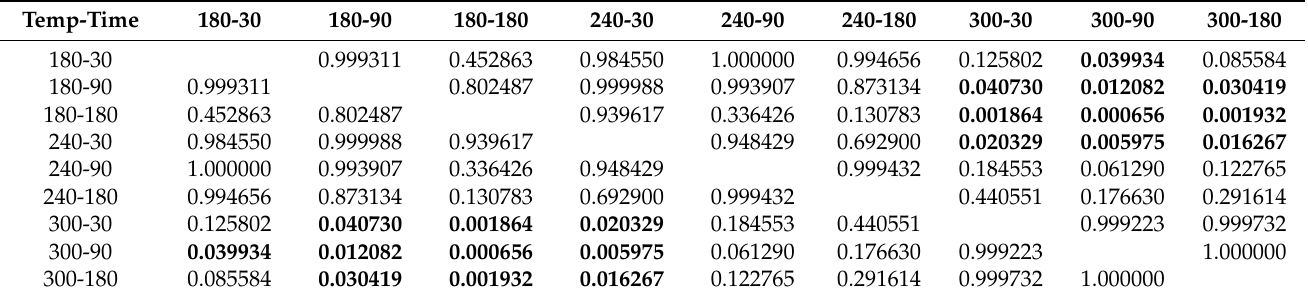
Table A16. Two-way analysis of variance (ANOVA) with post hoc Tukey test for MY , a bold font signifies a statistically significant difference ( p < 0.05).